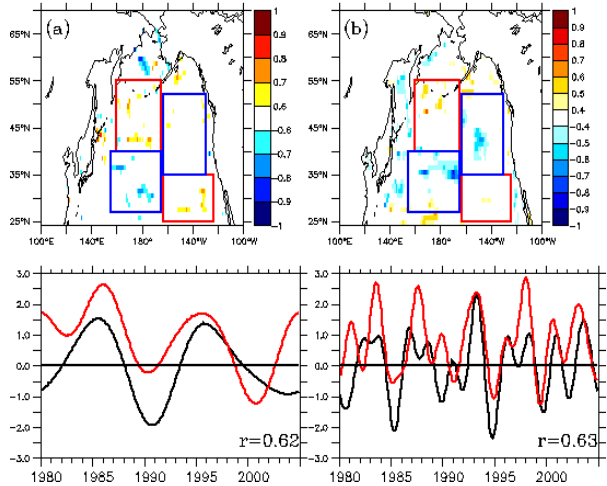
Fig. 6. Same as Fig. 4 left column but for separated components of (left) > 6.5 year cycles and (right) < 6.5 year cycles of net air-to- sea CO 2 flux anomalies and PDO. Correlations significant at 90% confidence interval are shaded. CO 2 flux data from assimilation are Figure 6: Same as Figure 4 left column but for separated components of (left) > 6.5 year cycles and 11 (right) < 6.5 year cycles of net air-to-sea CO 2 flux anomalies and PDO. Correlations significant at 90% 12 confidence interval are shaded. CO 2 flux data from assimilation are used. 13 14